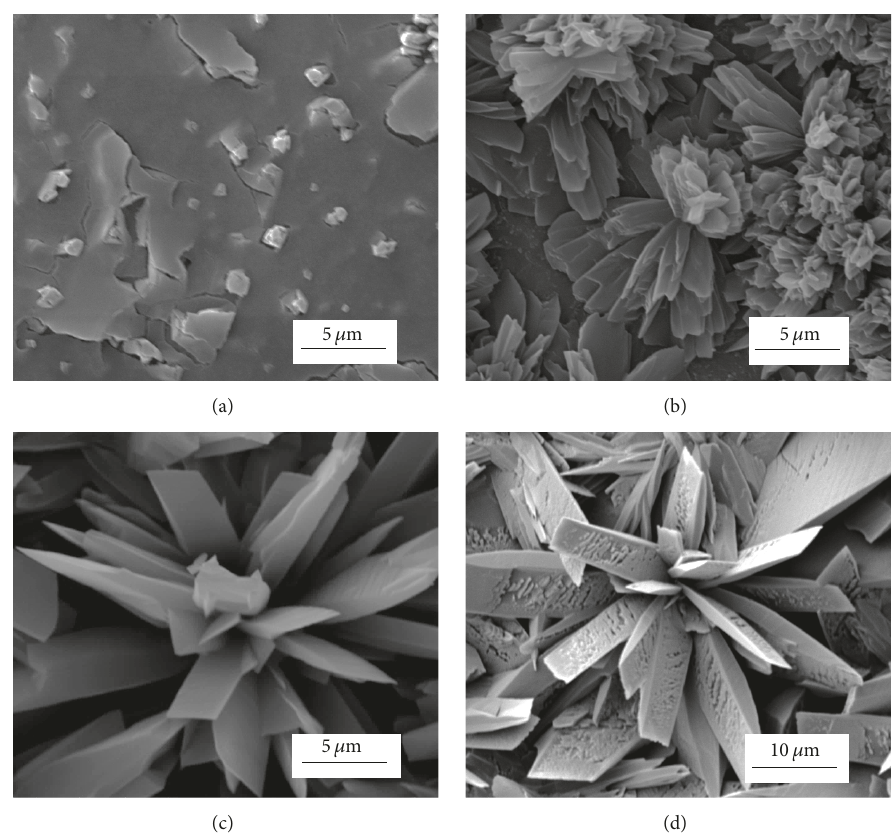
Figure 8: SEM images of Alq 3 crystals formed on one-step APA samples treated in 10 mM HQ solution for 10 min at different temperatures: 30 ∘ C (a); 60 ∘ C (b); 80 ∘ C (c); and 100 ∘ C (d).